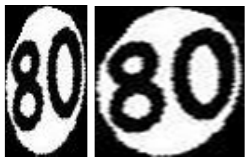
Figure 5. The influence of perspective projection can be diminished by size normal-